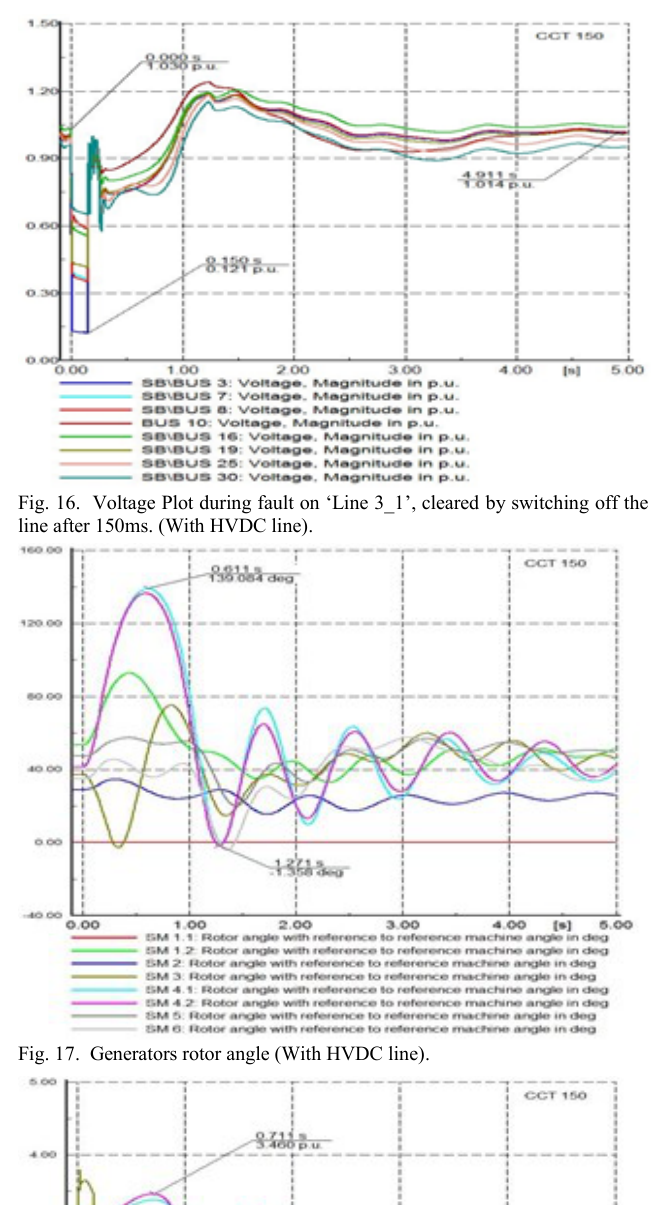
Fig. 17. Generators rotor angle (With HVDC line).